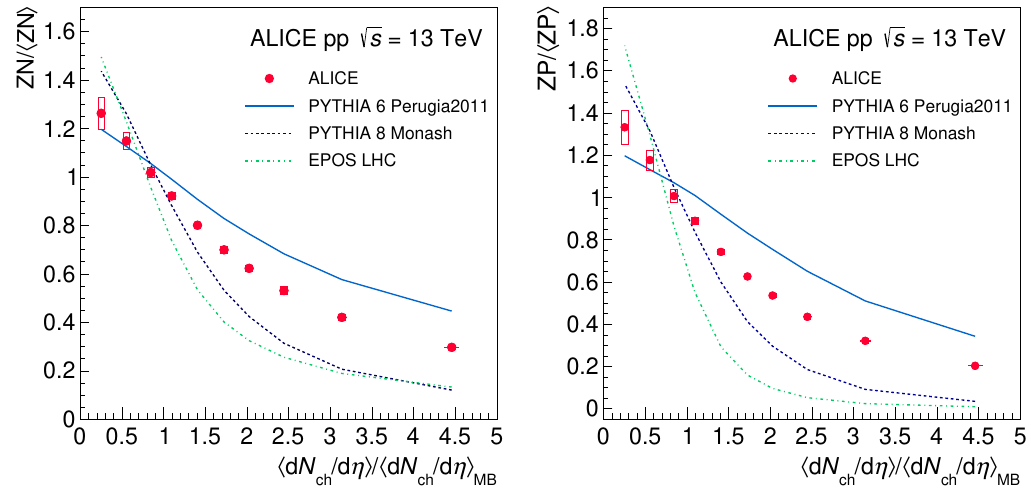
Figure 6 . Self-normalised ZN (left) and ZP (right) signals as a function of the normalised charged- particle multiplicity produced in | η | < 1 in pp collisions. Data (red markers) are compared with PYTHIA 6 (blue solid line), PYTHIA 8 (blue dashed line) and EPOS LHC (green dotted